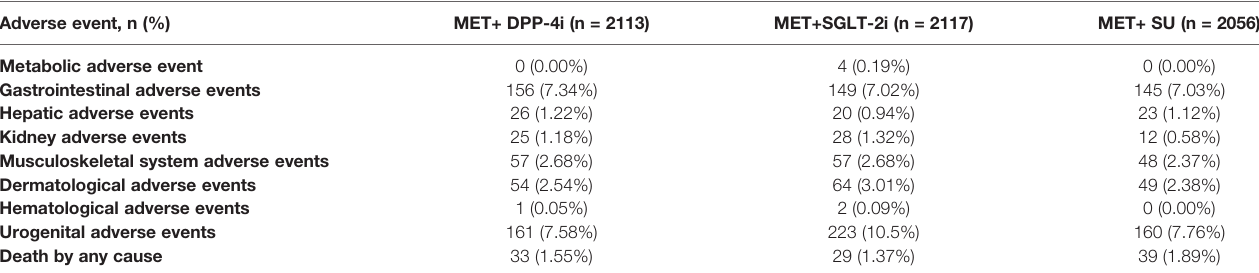
TABLE 3 | Adverse events among the treatment groups. Adverse event, n